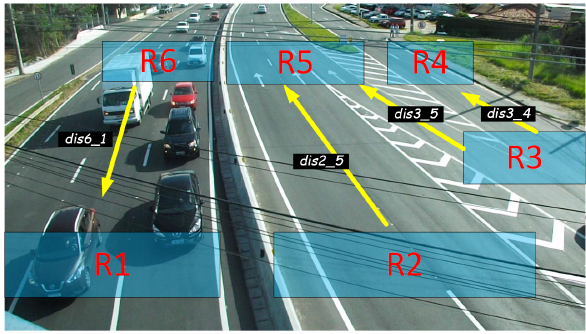
Figure 5. An example of the definition of regions for monitoring the movement of